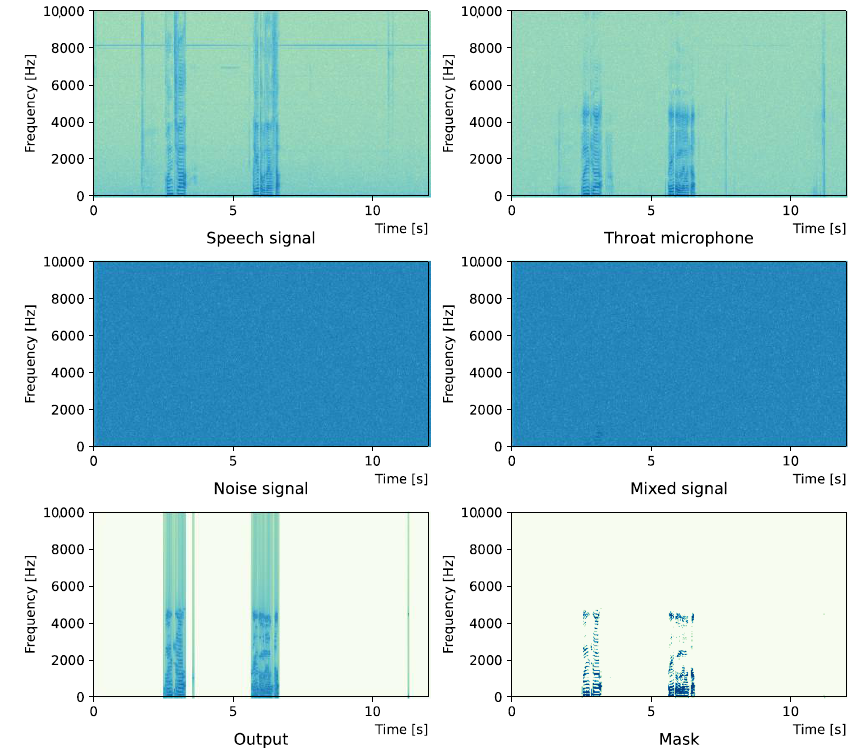
Figure 5. Spectrogram (White noise (0 dB)).